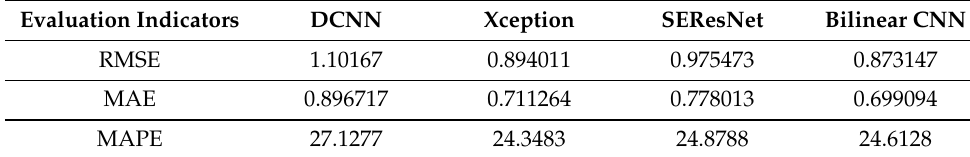
Table 4. Evaluation table for the prediction results of the median dataset.